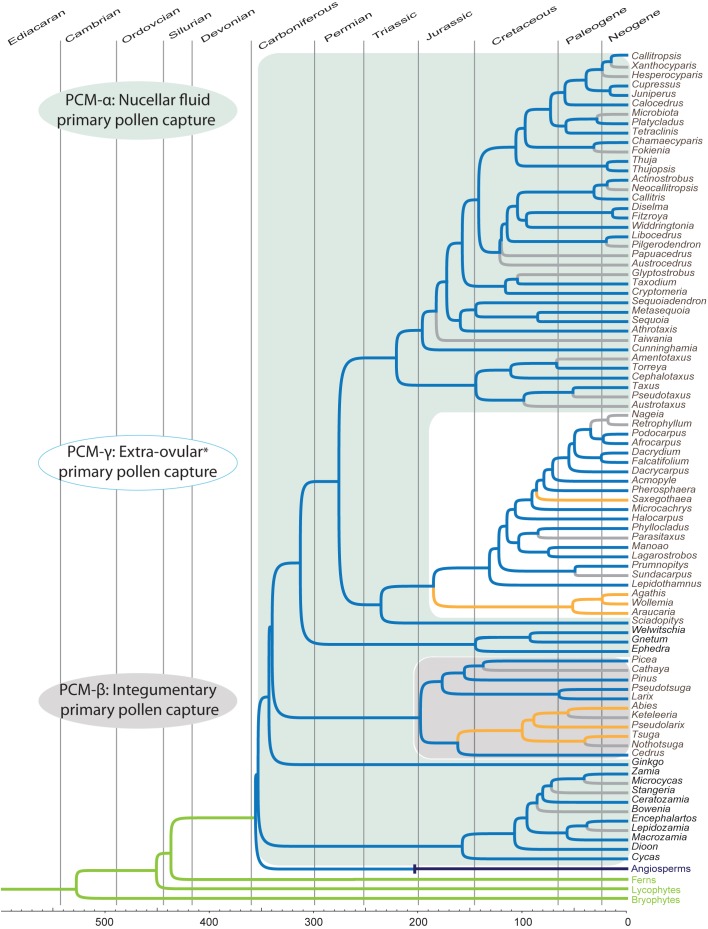
Chronogram of the extant genera of gymnosperms based on Lu et al. (2014), and Clarke et al. (2011) for relationships, and divergence times, of angiosperms and free-sporing plants. Blue branches represent presence of pollination drops sensu lato (i.e., where ovular secretions from the nucellus appear between pollen capture and fertilization). Gray branches represent missing data. Yellow branches represent well-studied taxa that have been reported to lack nucellar ovular fluids in their pollination (pollination drops, sensu lato). Green branches represent free-sporing sex, whether homo- or heterosporous. Purple branch for angiosperms represents flower-based sex; the origin is based on one of the divergence times from Clarke et al. (2011). Light blue enclosing rectangle represent the case of the most common pollen capture mechanism among extant taxa, PCM α: nucellar fluid performing the functions of: (i) capture of non-saccate pollen, (ii) delivery of pollen into the ovule interior, (iii) germination medium of pollen, and (iv) ovule defense. Gray rectangle represents the shift to primary pollen capture by integuments in Pinaceae, PCM β. White rectangle represents the shift to various ovular, and extra-ovular primary capture mechanisms (PCM γ) in Podocarpaceae sensu lato and Araucariacae. Note that Saxegothaea, and Araucariaceae lack drops. Extinct fossil seed plants not shown; the earliest plants with seed-like structures appear in the Upper Devonian. Data for drop presence/absence from: Norén (1908), Tison (1911), Saxton (1913a,b), Doyle and Saxton (1932), Brough and Taylor (1940), Doyle (1945), Dogra (1964), Tang (1987, 1993), Takaso (1990), Tomlinson (1991, 1992, 1994), Tomlinson et al. (1991, 1997), Carafa et al. (1992), Takaso and Tomlinson (1992), Kato et al. (1995), Molloy (1995), Owens et al. (1995), Takaso and Owens (1996a, 2008), Möller et al. (2000), Mill et al. (2001), Zhuowen (2004), and Li and Huang (2006).